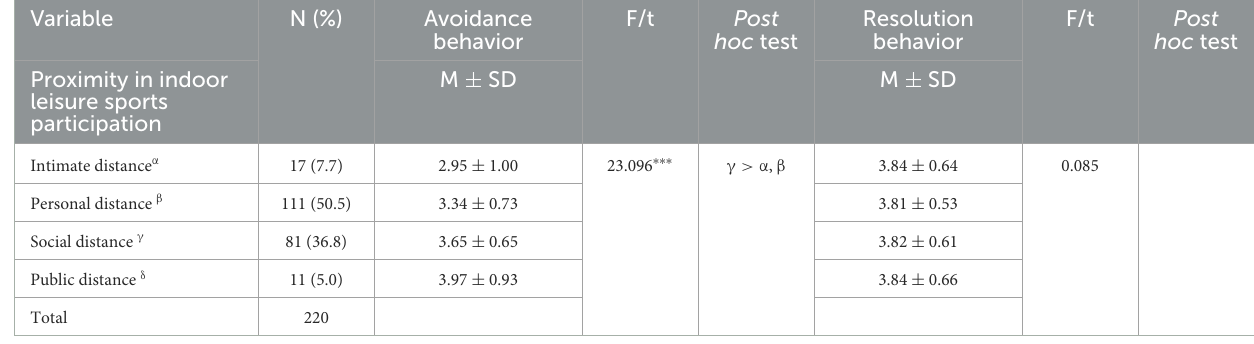
TABLE 7 Differences in coping strategies depending on spatial proximity among indoor leisure sports ( N = 220).